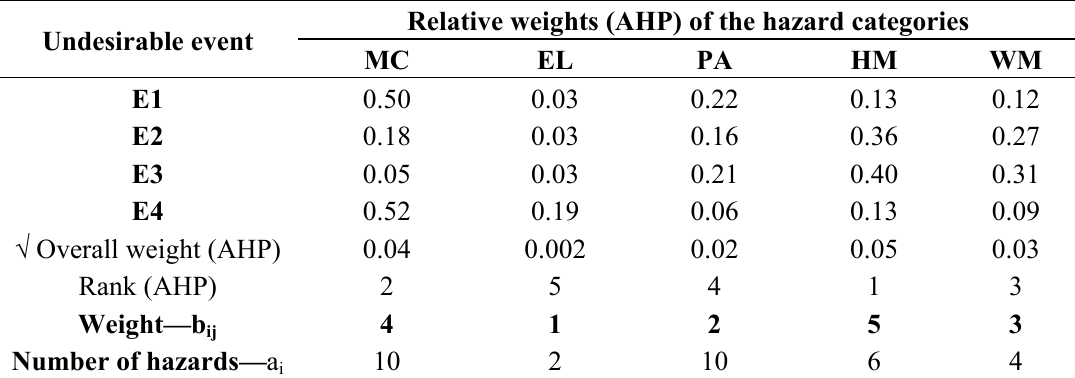
Table 5. Weight calculation of the hazard